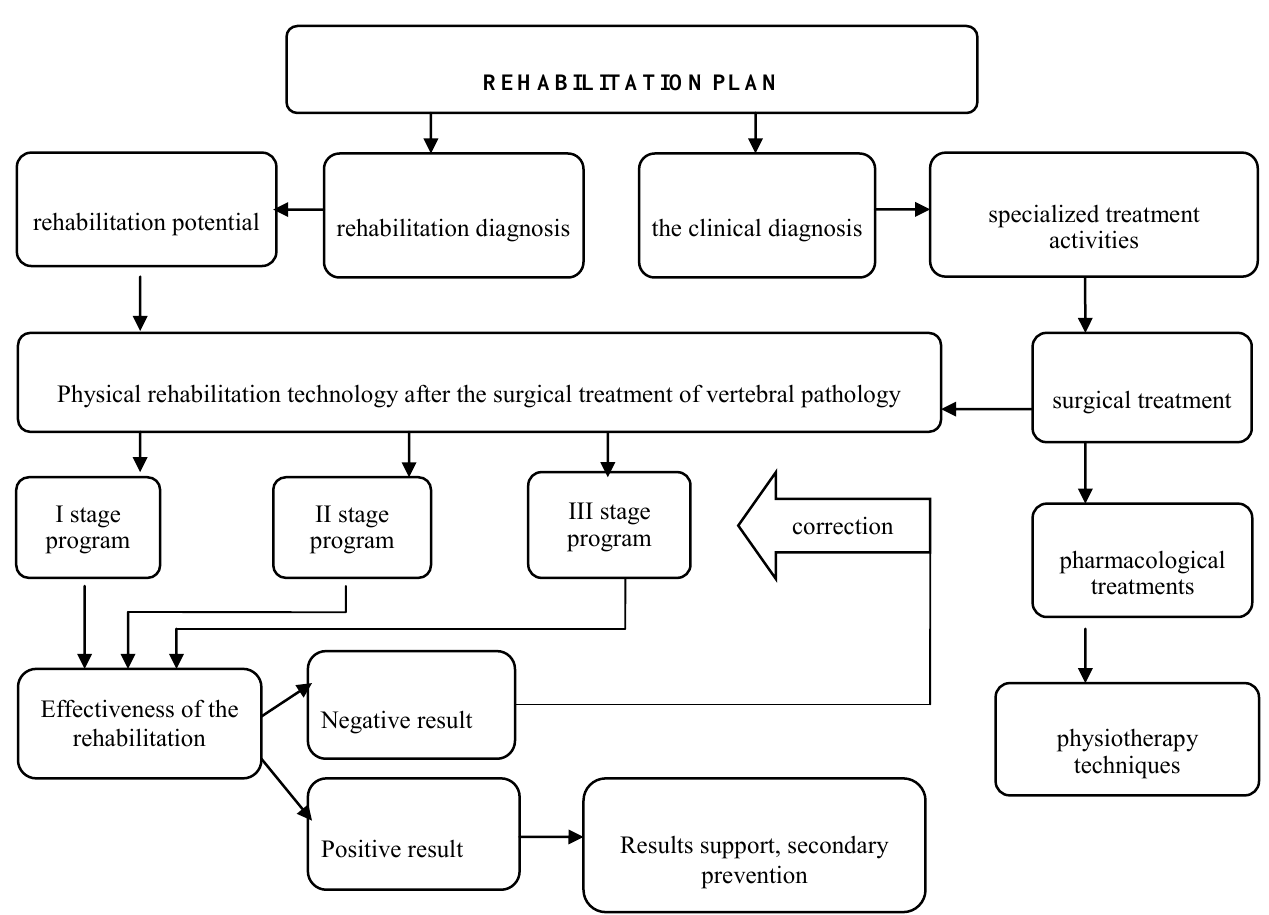
Fig. 1. Strategical framework of the rehabilitation process for patients after the surgical treatment of back